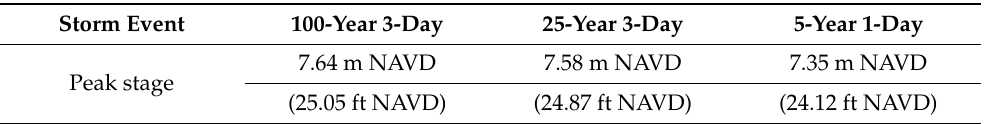
Table 6. Summary of the post-development peak